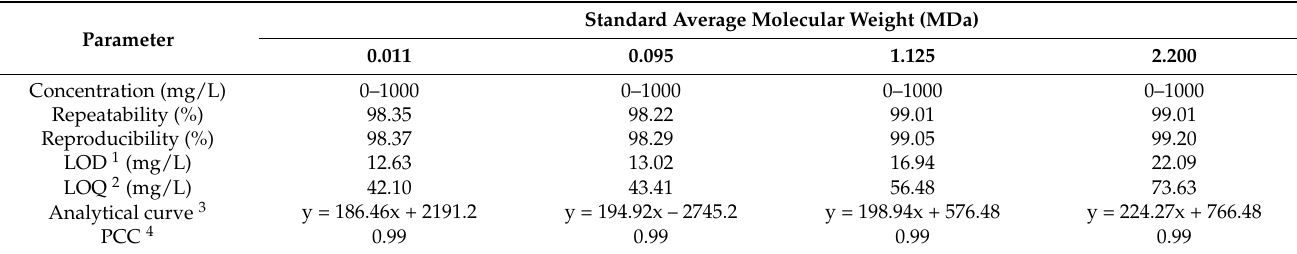
Table 2. Quantitative parameters for analytical validation of the HPLC-SEC